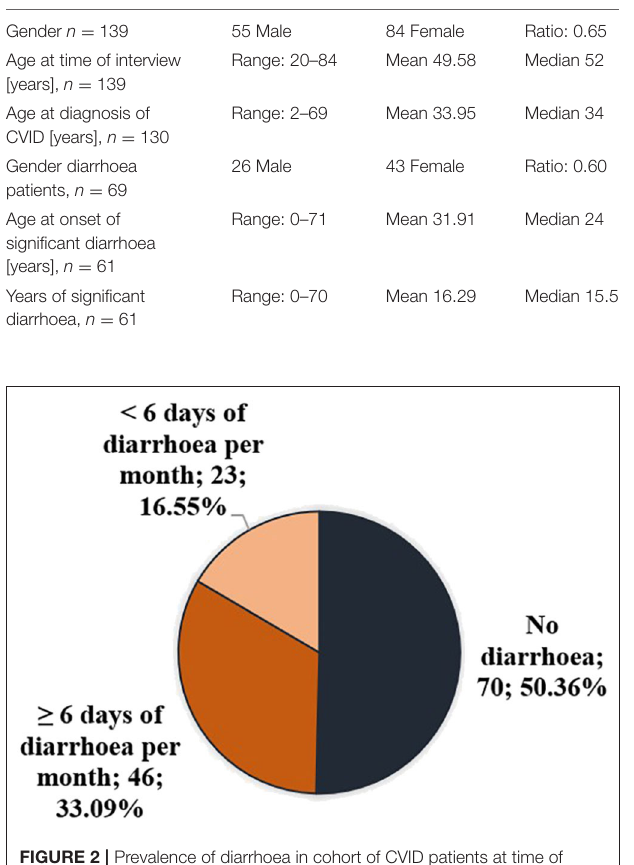
FIGURE 2 | Prevalence of diarrhoea in cohort of CVID patients at time of